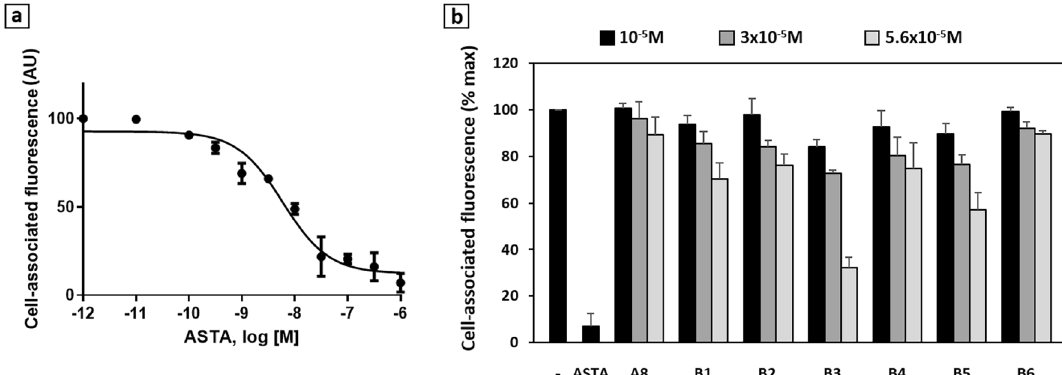
Figure 6. In vitro competitive binding assays for the B-series molecules. ( a ) Competition curve for the native ligand ASTA on HEK cells (4 replicates). ( b ) Results (% max) for the 6 tested B molecules, as compared with those of A8 and ASTA (10 –6 M) (5